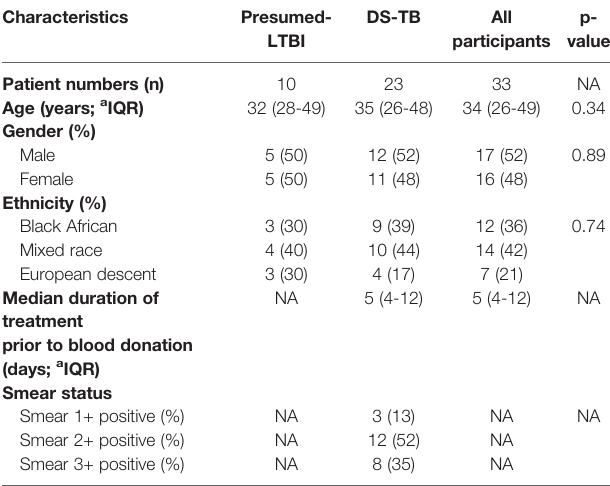
TABLE 1 | Demographics and clinical characteristics of participants with latent TB infection (LTBI) and drug-sensitive TB (DS-TB).